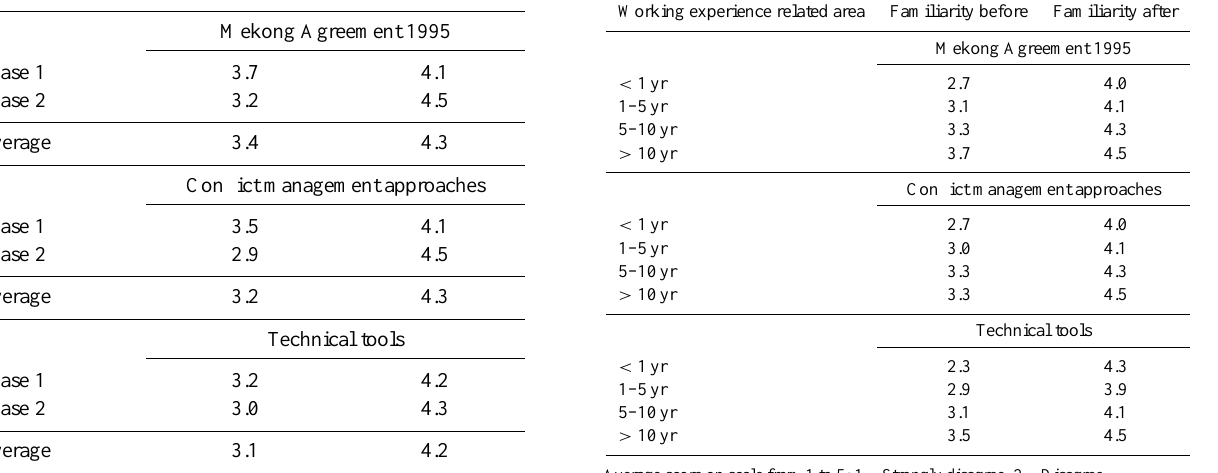
Table 4. Familiarity with three knowledge areas taught in relation to addressing transboundary issues before and after the MRC-FMMP Capacity Building Programme, per phase ( n = 37) ∗ .